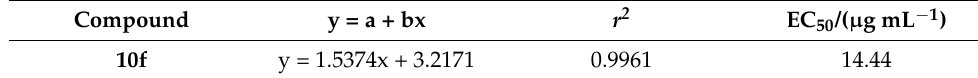
Table 2. EC 50 of compounds 10f to Botrytis cinereal